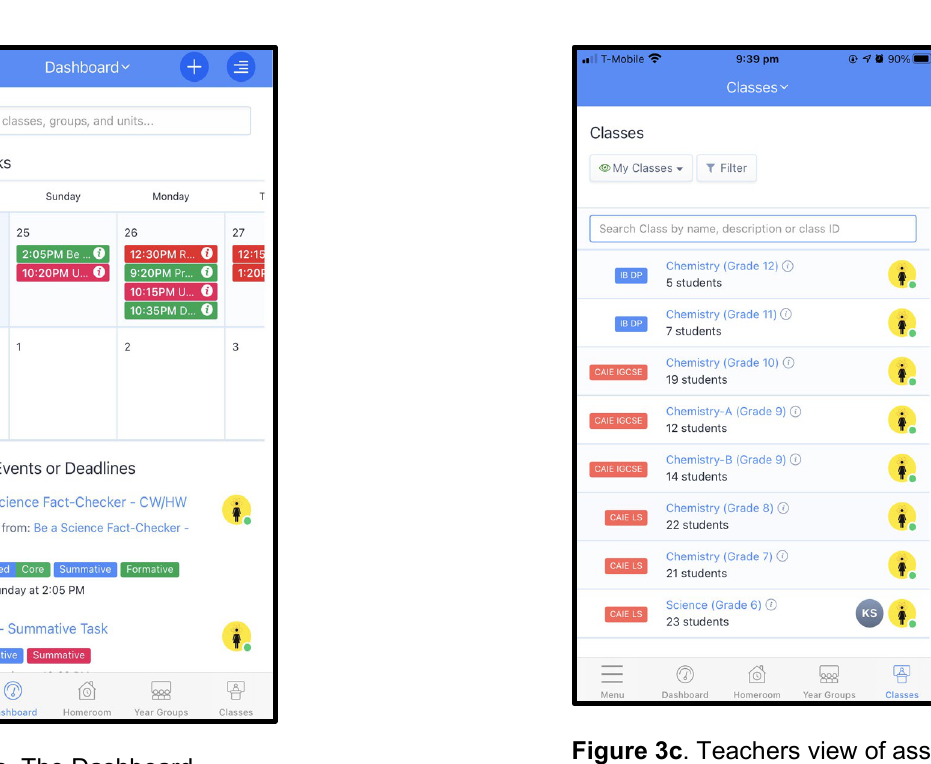
Figure 3a. The Dashboard